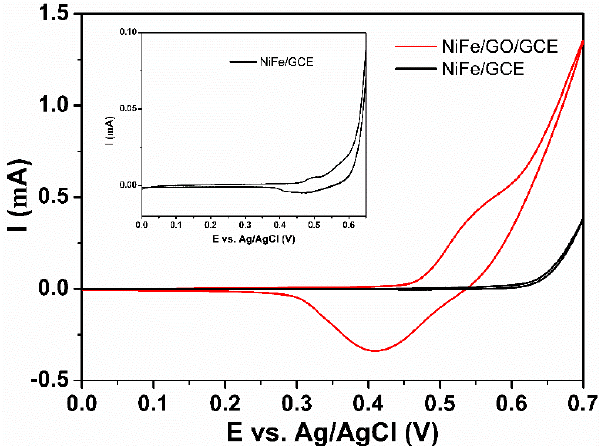
Figure 4. CVs of NiFe/GCE and NiFe/GO/GCE in 0.1 M NaOH solution in the presence of 1.0 mM glucose at a scan rate of 10 mV/s. Inset: CV of NiFe/GCE.